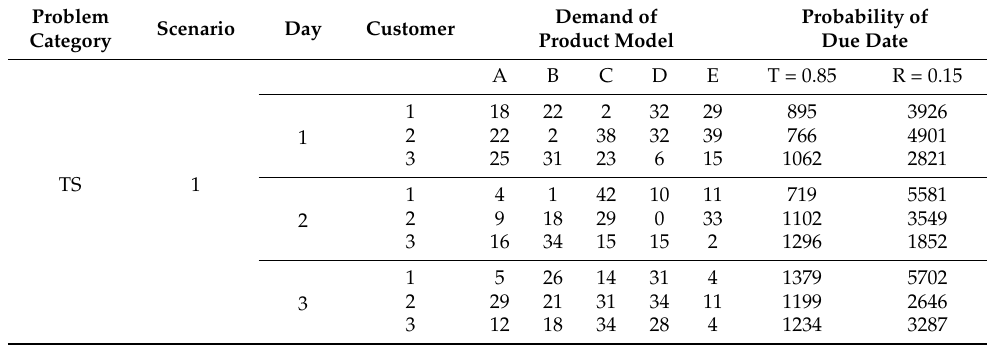
Table 2. Demand of product models from different customers received on three consecutive days.